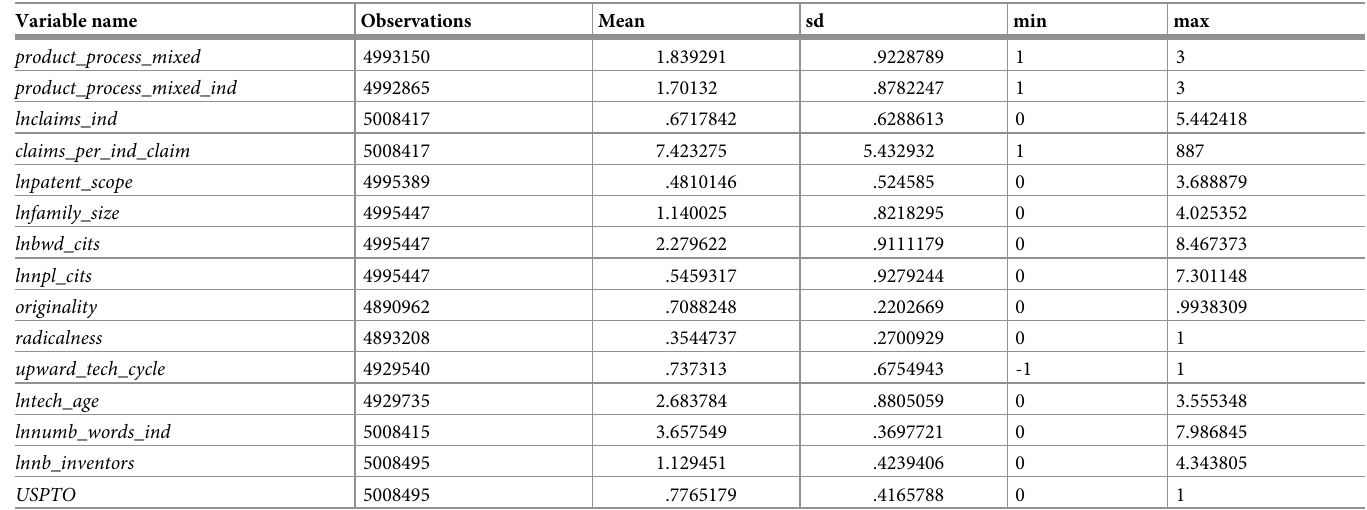
Table 3. Descriptive statistics of